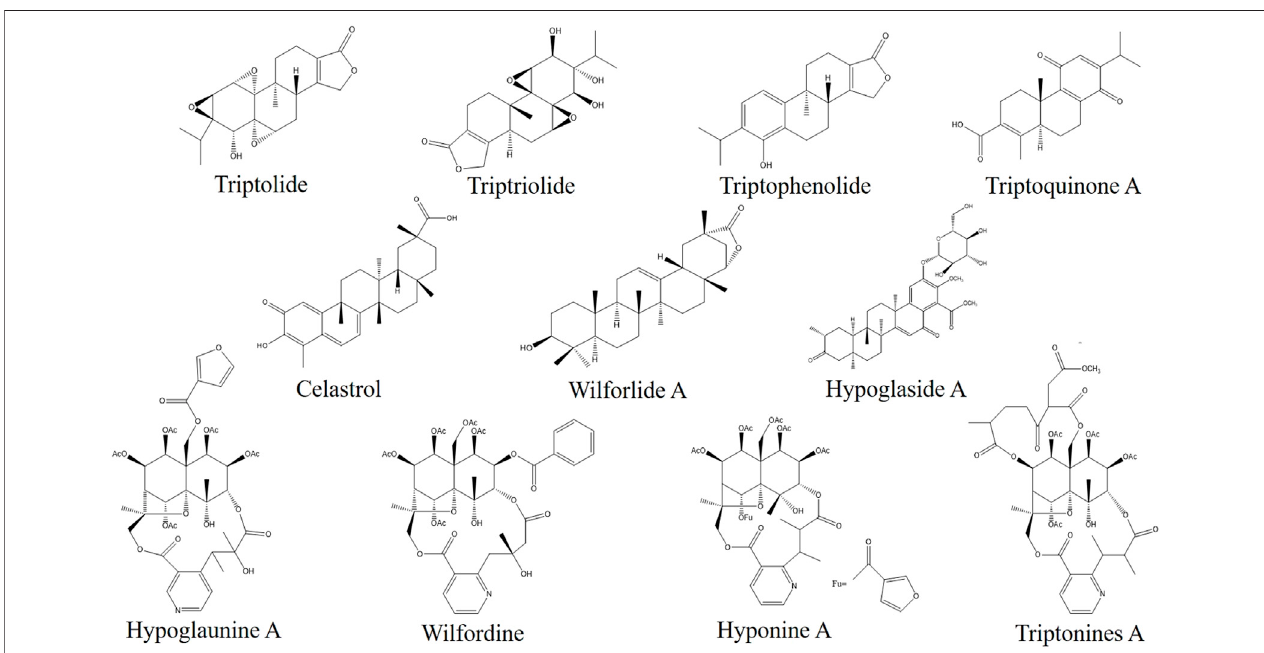
FIGURE 3 | Chemical structures of the existing potential quality control markers in